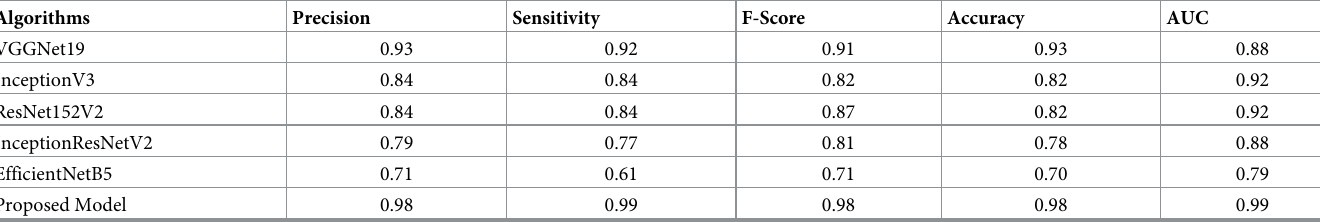
Table 3. Performance comparison of proposed model with pre-trained models on Private dataset.